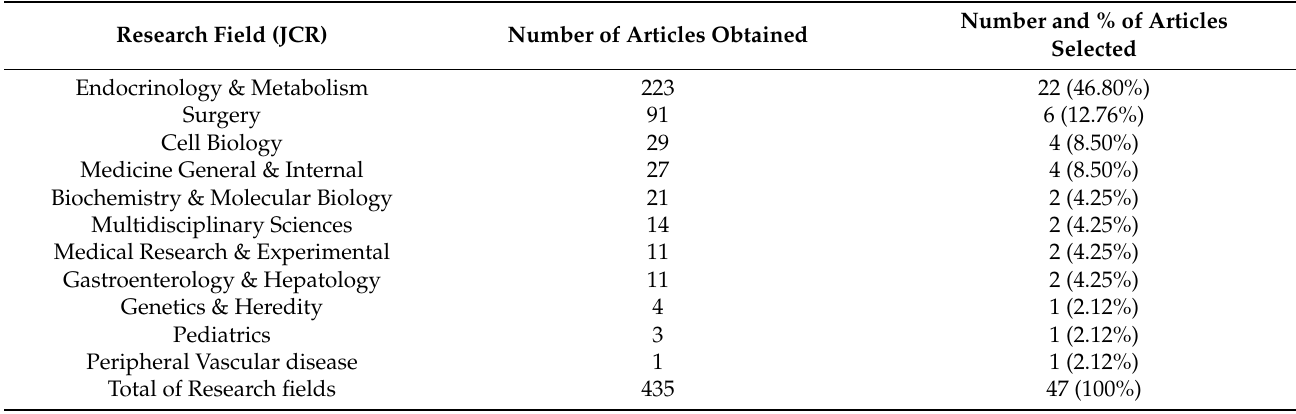
Table 1. Search Results. Break down of the total number of articles used to prepare the work. The left column represents the different fields of research of each journal citation (Journal Citation Report categories). The central column contains the number of citations found in each category and the right column contains the number and percentage of citations selected for the